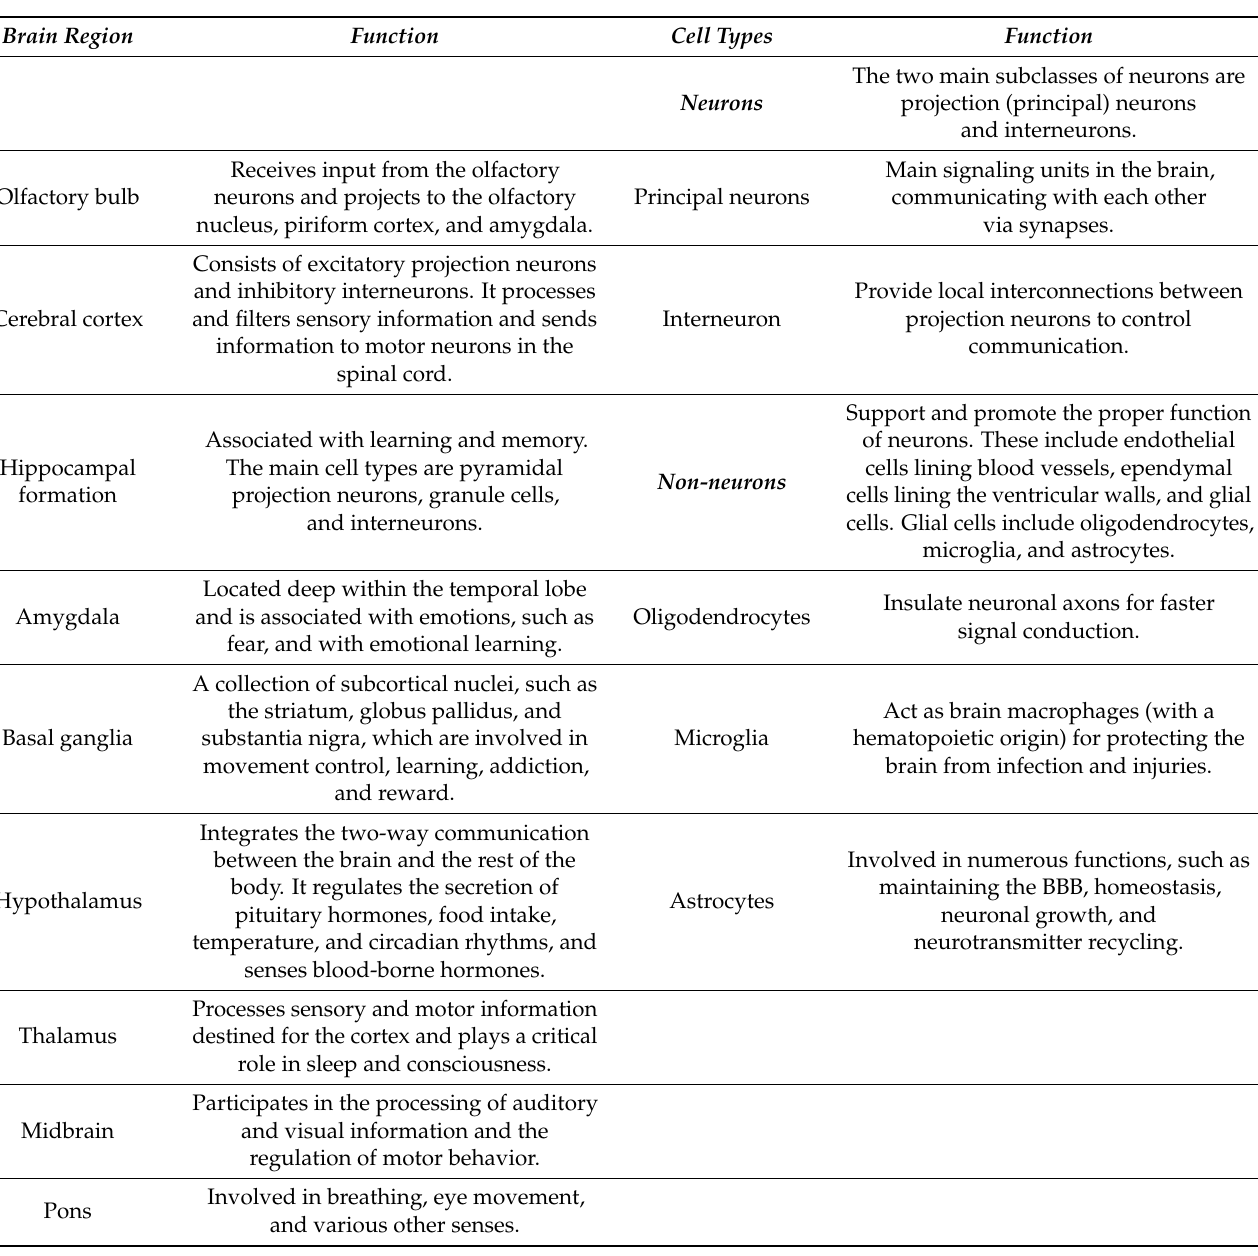
Table 1. An overview of human brain regions, cell types, and their